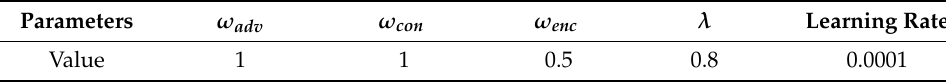
Table 4. The parameters of the model.